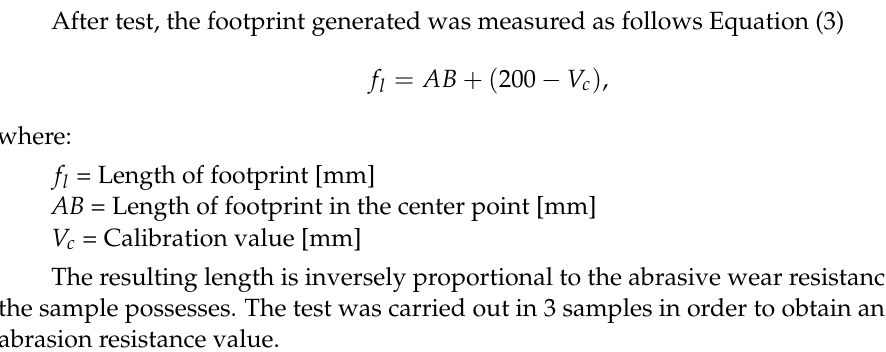
Figure 5. Sketch of wear resistance test for commercial and sand/plastic cobbles.